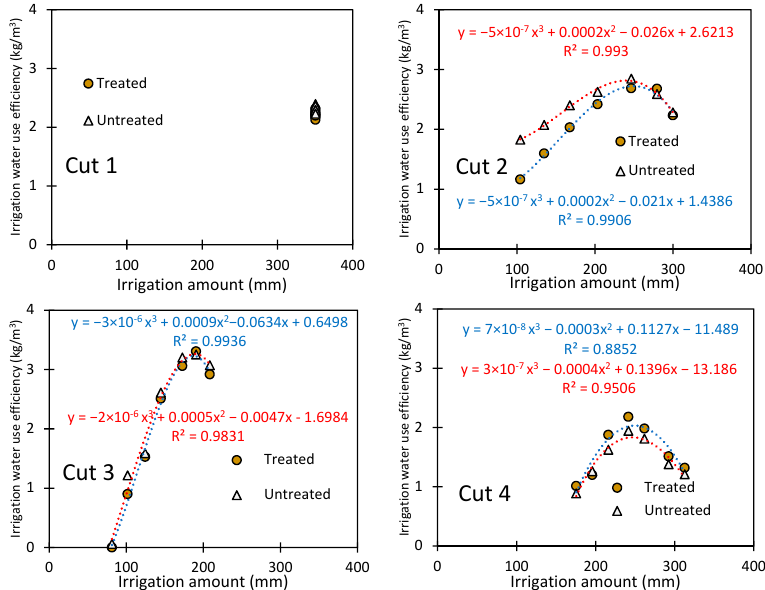
Figure 5. Irrigation water use efficiency of alfalfa as function of irrigation amount at each cut during the 2013 growing season.